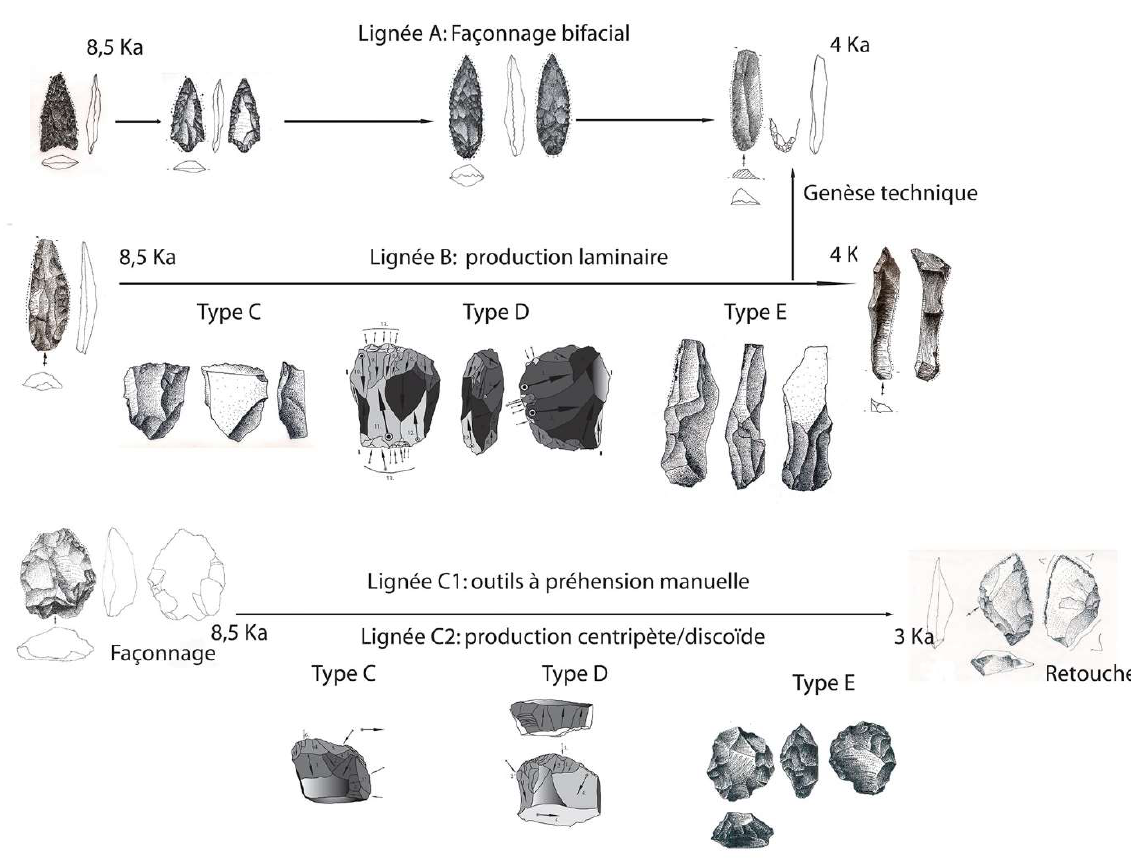
Figure 19. Exemples de lignées techniques en Amérique du